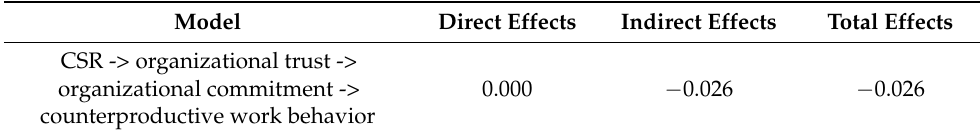
Table 3. Direct, indirect, and total effects of the final research model.